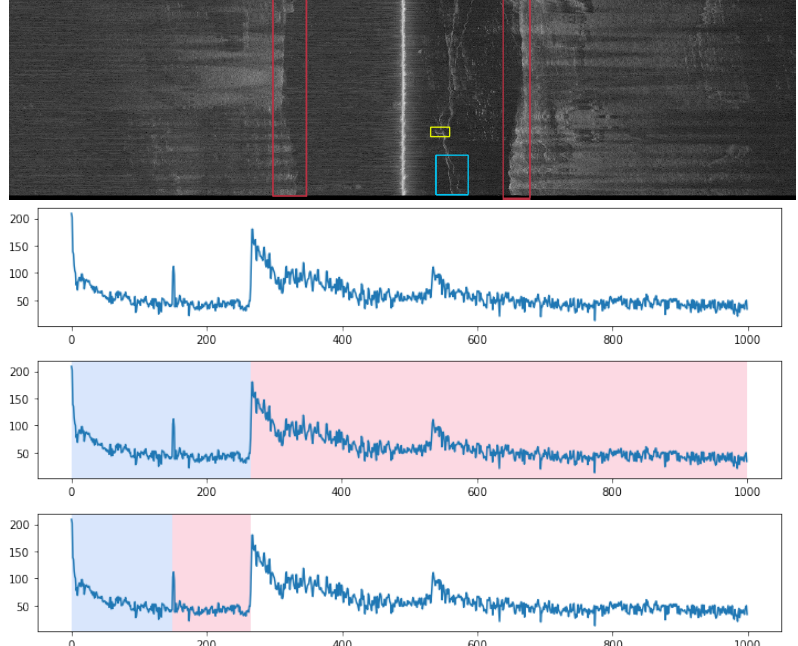
Figure 7. ( Top ): A sidescan sonar “waterfall image” of parts of the seaweed farm. ( Three bottom plots ): The red, blue, and yellow annotations correspond to the nadir, rope, and buoy signals, respectively. The three graphs show the port sidescan sonar signal (a row of the top image) and the corresponding nadir and rope segmentation